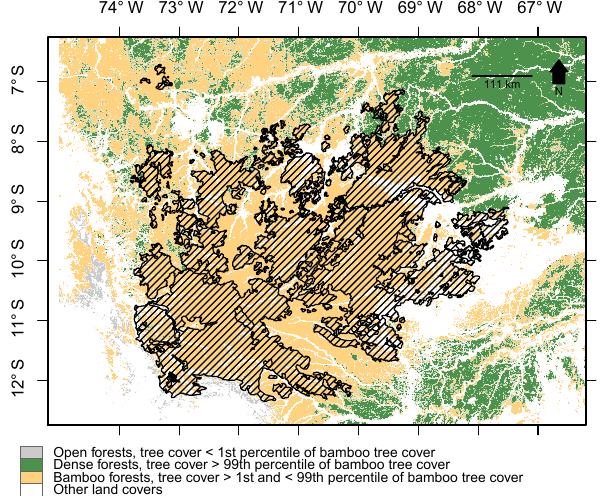
Figure 3. Spatial distribution of stable tree cover percentage per- centiles (filtered for tree cover gain and loss and for waterbodies), indicating pixels below, above and within the 1st to 99th percentile range of tree cover found in bamboo-dominated forest (hatched), as delineated by Carvalho et al.